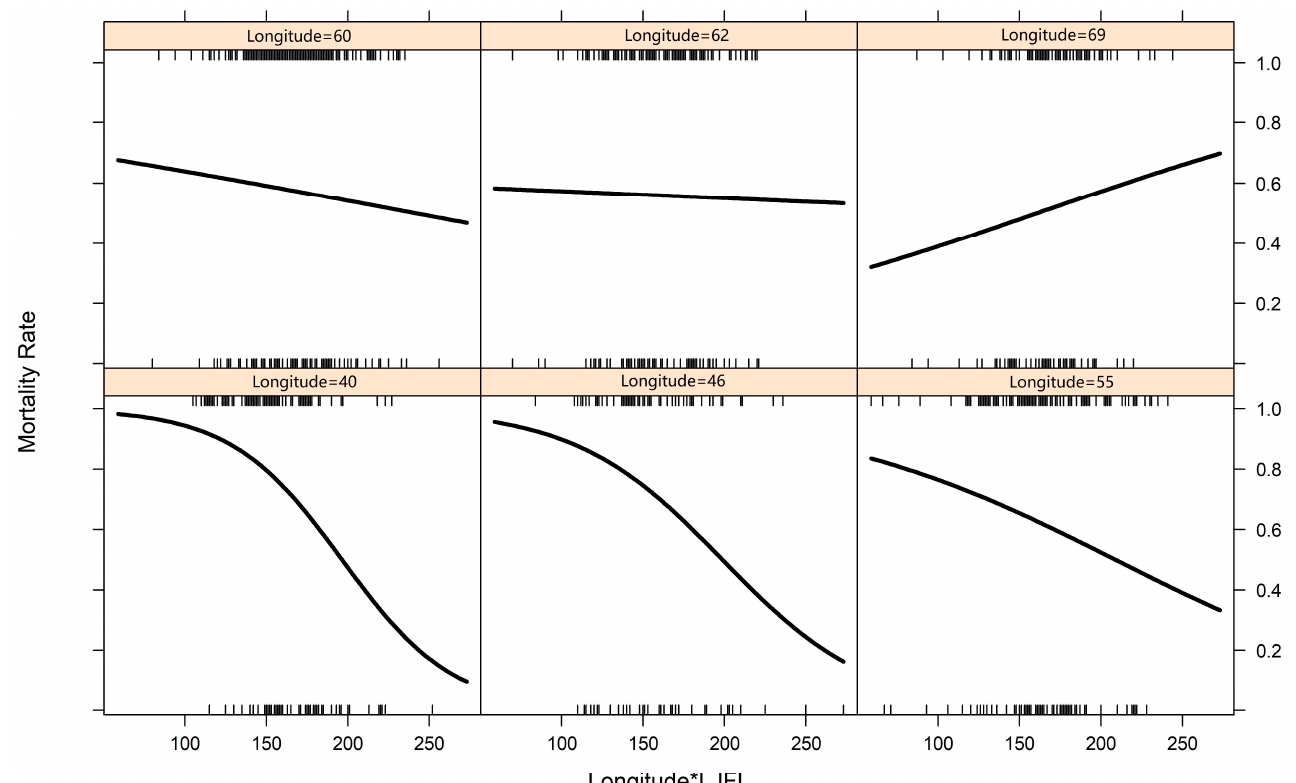
Figure 6. The effect of the interaction term between longitude and lower jaw fork length (LJFL) on the at-haulback mortality of Indian Ocean swordfish. The different boxes indicate the variation of the at-haulback mortality with LJFL for swordfish caught at different longitudes. The short lines at the top and bottom of the picture respectively indicate the number of samples that died and survived under the LJFL.